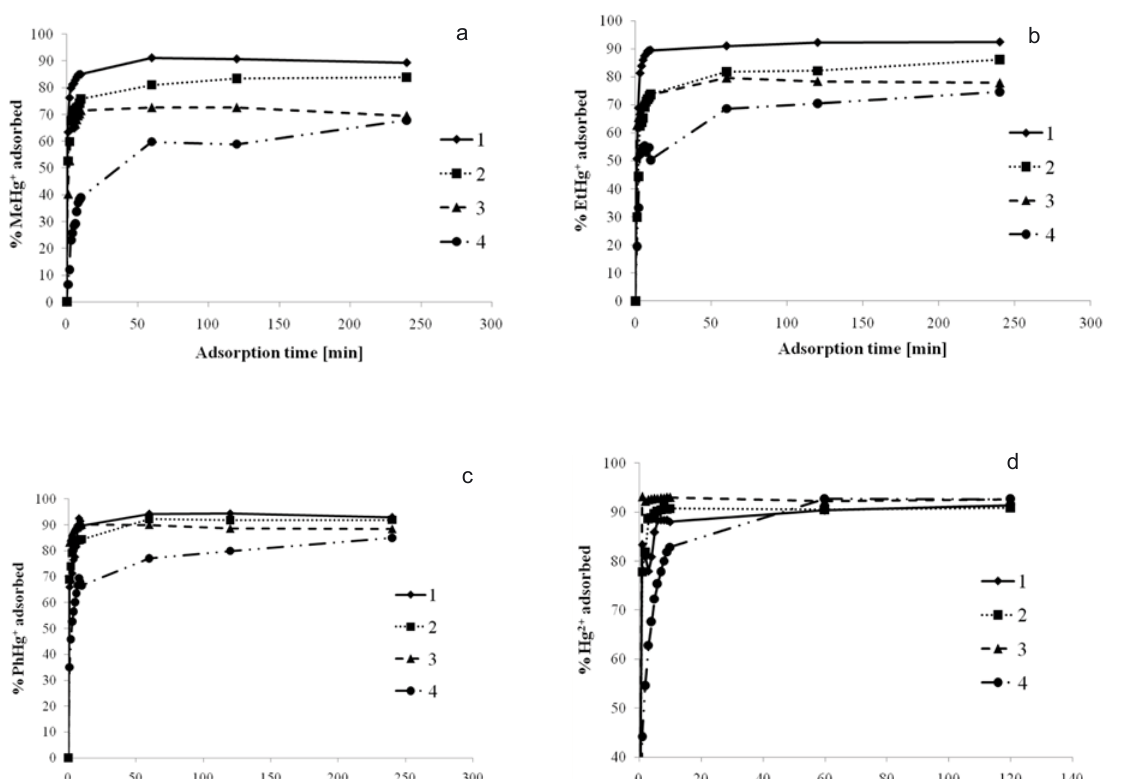
Figure 7. Effect of urea, thiourea and L-cysteine (agitated system, 20 g of ZL 1606 sediment, 250 mL of water, pH 5.2, Hg concentration 0.2 mg L -1 , T = 22.3°C); (1) without S-compound, (2) 0.2 g L -1 urea, (3) 0.2 g L -1 thiourea, (4) 0.2 g L -1 L-cysteine